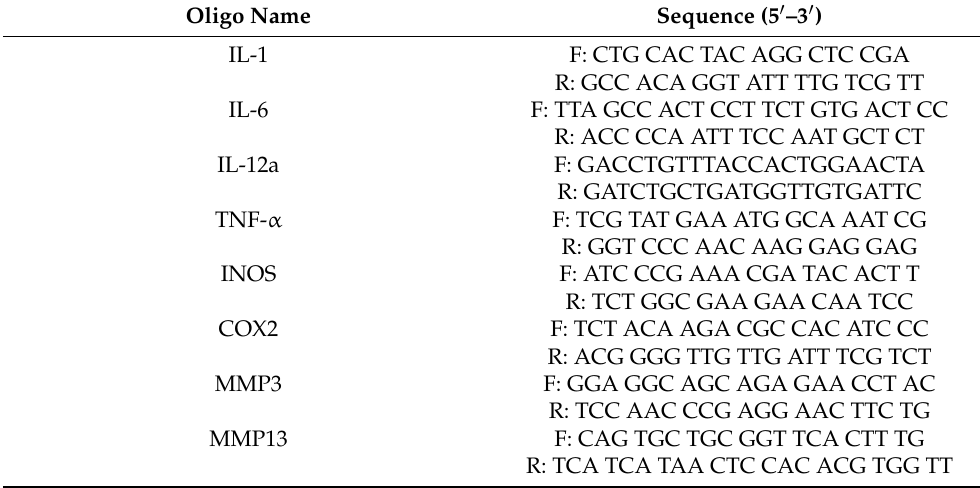
Table 1. Primer sequences in